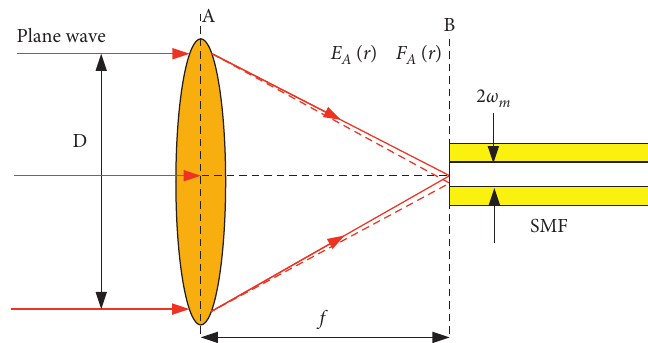
Figure 1: Schematic diagram of plane wave coupling to SMF.